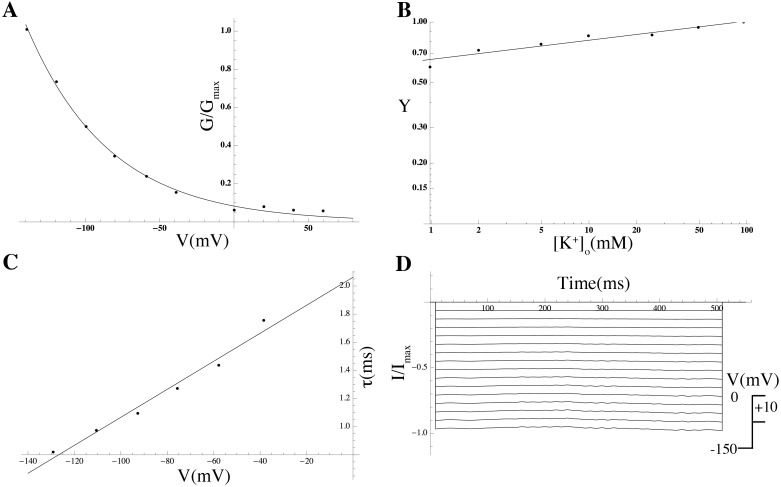
Properties of IKir7.1.(A) Steady state activation curve from Doring et al [35] fit by a single exponential. (B) Double logarithmic plot for the Kir7.1 conductance as a function of [K+]o. (C) Activation time constant derived from experimental data (filled circles) from Doring et al [35]. (D) Current trace in simulated voltage-clamp experiments. Currents are recorded during 1 s voltage steps to potentials up to −150 mV from a holding potential of 0 mV. Values are normalised to the peak current values.